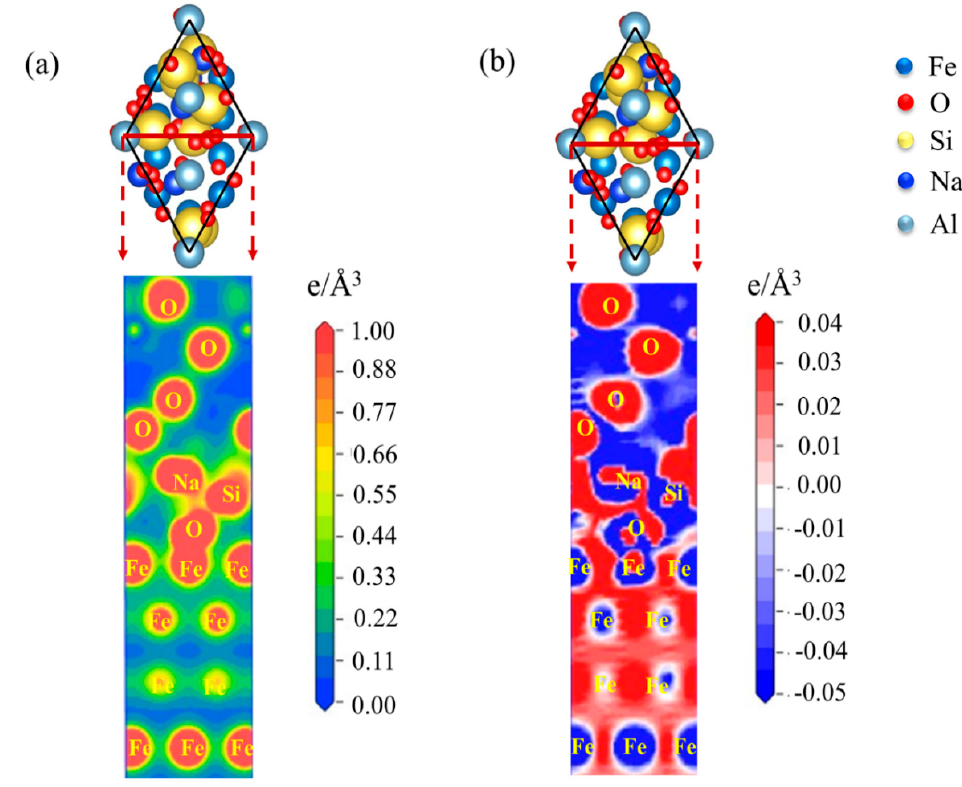
Figure 11. The ( a ) charge density and ( b ) charge density difference of the Fe-amorphous Na 2 SiO 3 - Al 2 O 3 interface at (001) crystal plane.